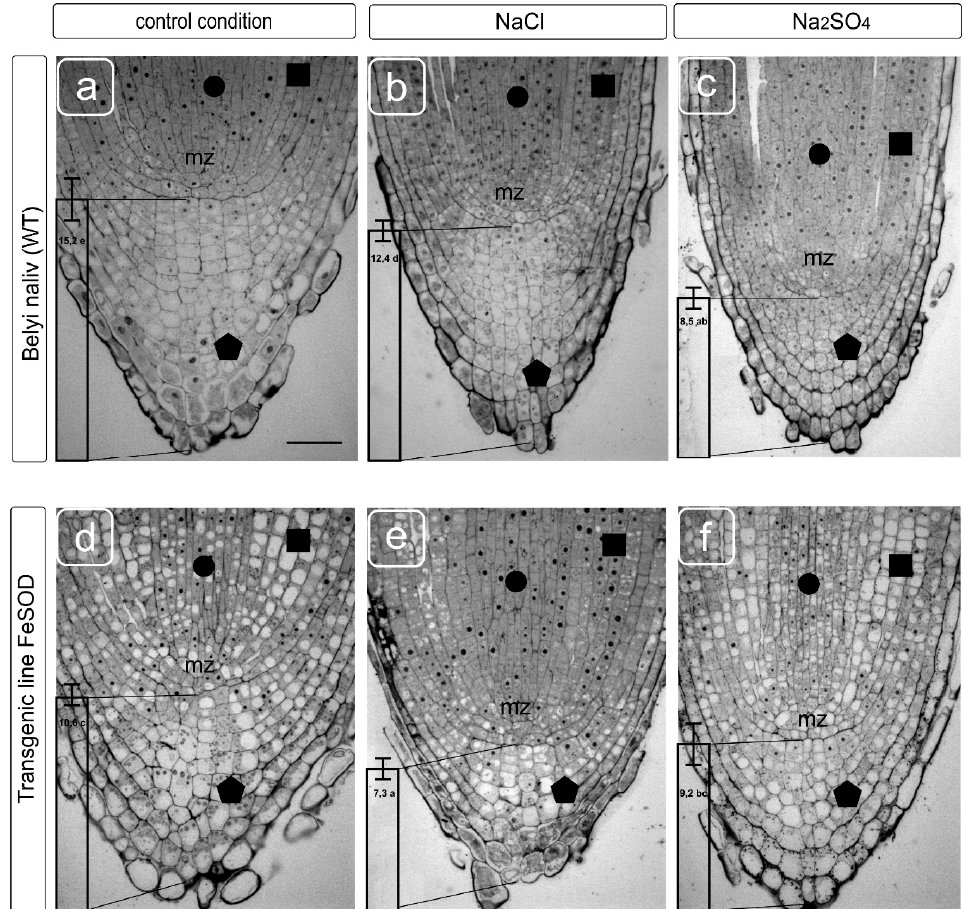
Figure 1. Transverse sections of root tips from wild-type (WT) ( a – c ) and transgenic tomato ( d – f ) plants grown without and supplemented with NaCl and Na 2 SO 4 . Modification of meristem and cap cells while the imitation of salinity effects in vitro culture. Responsiveness of the following parameters to salt stress is shown: the size and shape of the columella zone cells from the root cap (indicated by a vertical column with an average number of columella cell layers) and the initials extending from the meristematic zone (mz) from the root tip. Symbols: circle–stele cells, square–cortex cells, pentagon–columella cells. Scale bar: 50 μ m. Transverse sections of root tips show the average number of columella cell layers. Values followed by the same letter significantly do not differ by Duncan’s test ( α = 0.05) (50 transverse sections of root tips from five independent plants). A statolith formation and starch deposition in them is an important indicator of the cap development and, partially, of the outer cortical cells development, represented by epidermal and sub-epidermal tissue. The amount of starch depends on sucrose from the aboveground part due to phloem transport, which is converted into starch deposits of statoliths. The statoliths provide